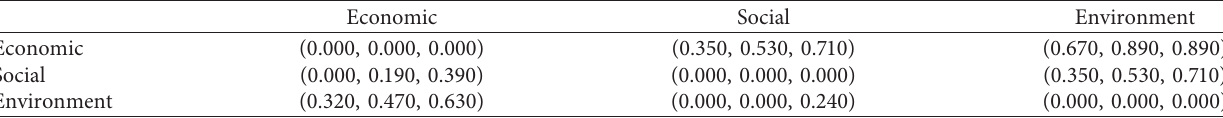
Table 16: Comparison matrix of the linguistic variable of sustainability dimensions in Z-number condition.